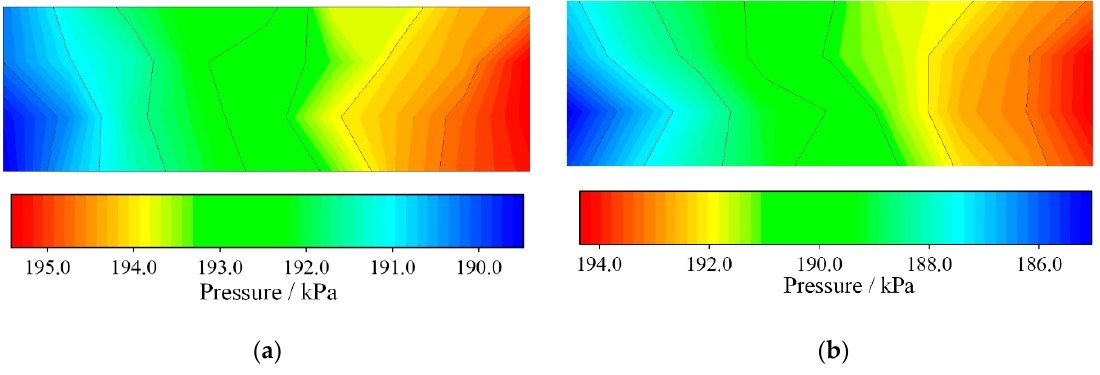
Figure 4. Pressure dynamics in the cathode channel, from the experiment: ( a ) under current of 111.6 A, ( b ) under current of 167.4 A.